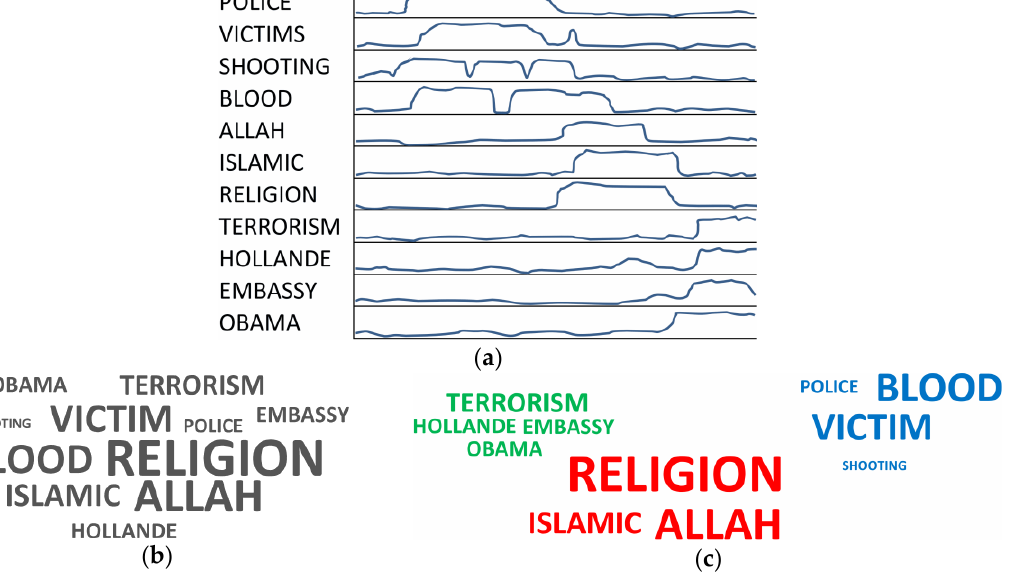
Figure 1. ( a ) Terms and temporal series; ( b ) Term Cloud; ( c ) Relational Term Cloud.